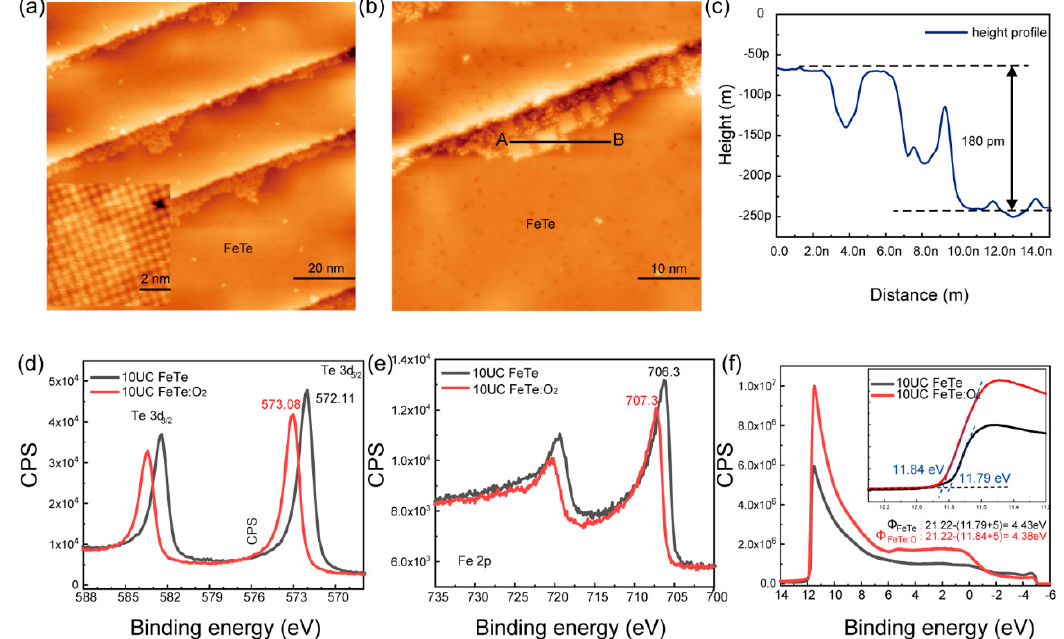
Figure 2. (Color online) ( a ) Surface topography (100 nm × 100 nm) of the 10UC FeTe films after exposure to oxygen partial pressure of 1.6 × 10 − 4 mbar for 15 min at RT. Scanning condition: sample bias V s = 1 V, tunneling current I t = 100 pA. O 2 overlayers were initially formed along the step edge. Inset is the atomically resolved STM image of the uncovered clean FeTe surface. ( b ) Enlarged STM image (50 nm × 50 nm) of O 2 overlayers (FeTe : O 2 ) on FeTe surface. Scanning condition: sample bias V s = 0.50 V, tunneling current I t = 100 pA. ( c ) The height profile of FeTe : O 2 along line AB in panel b. ( d , e ) XPS core-level spectra of Te 3d ( d ) and Fe 2p ( e ) on as-prepared 10 UC FeTe and FeTe : O 2 covered surface, respectively. No trance of Te-O and Fe-O signals can be observed. The spectra show apparent peak shifts after oxygen adsorption. ( f ) UPS spectra of 10UC FeTe covered w / o FeTe : O 2 , and the added voltage here is − 5 V. Inset is the large view.